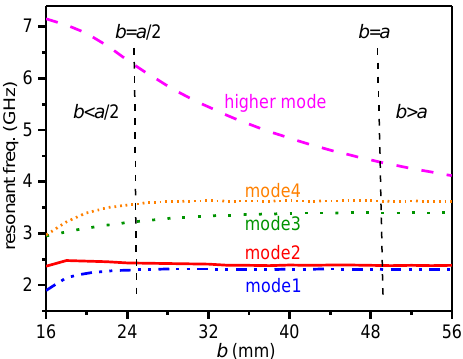
Figure 7. Resonant frequencies against height of the waveguide cavity b .